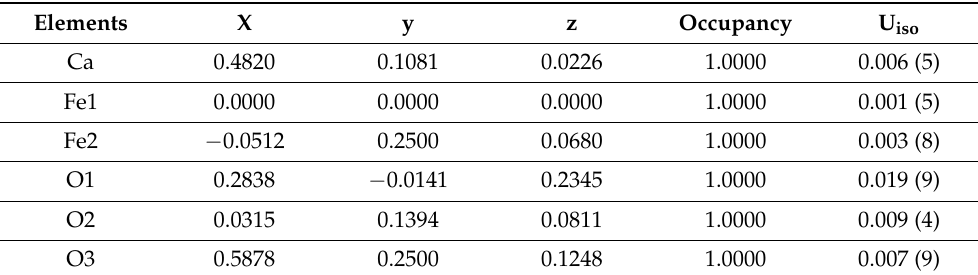
Table 1. The structural parameters for Ca 2 Fe 2 O 5 obtained from the refinement of powder X-ray diffraction. Space group: Pnma , a = 5.4247 (5), b = 14.7756 (1), c = 5.5977 (5), Rp = 0.013, wRp = 0.018, and χ 2 = 1.941.